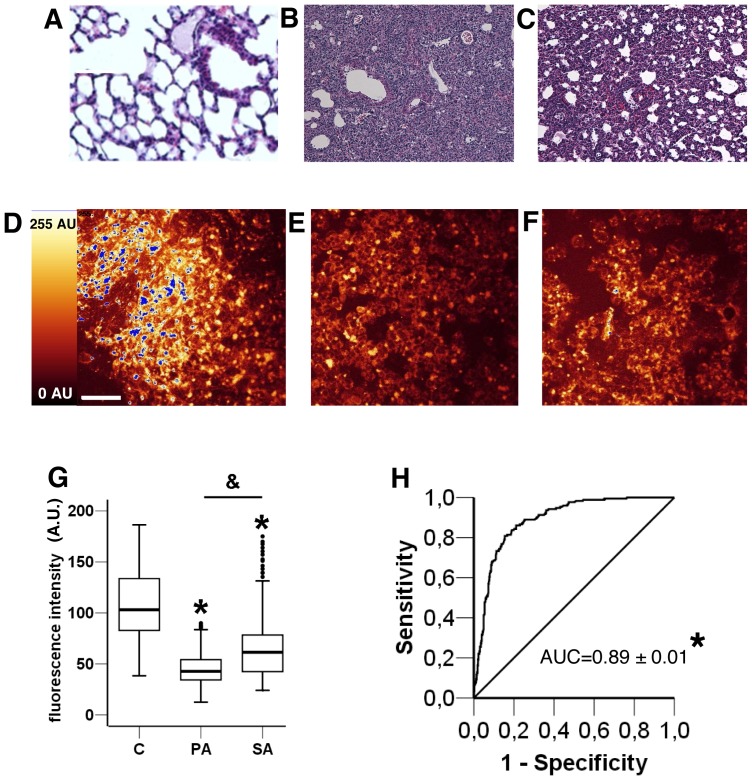
Fluorescence intensity and histology images of BAL in control and Pseudomonas aeruginosa- or Staphylococcus aureus–induced pneumonia mice.Control condition histology (A) and fluorescence intensity imaging (D); Staphylococcus aureus-induced pneumonia histology (B) and fluorescence intensity imaging (E); Pseudomonas aeruginosa-induced pneumonia histology (C) and fluorescence intensity imaging (F). Scale bar, 50 μm. (G) Boxplot representation of fluorescence intensity in arbitrary units (I (AU)) of BAL for non infected mice (control, C) and Pseudomonas aeruginosa (PA) or Staphylococcus aureus (SA) induced pneumonia in mice. Boxes represent median (interquartile range). Data are representative of two independent experiments (Control group, n = 8; Pseudomonas aeruginosa group, n = 9; Staphylococcus aureus group, n = 12). ANOVA with post-hoc analysis by t-test using Bonferroni's correction was used to compare autofluorescence levels between each group. *: p<10−4
Pseudomonas aeruginosa and Staphylococcus aureus groups versus control group. &: p<10−4
Pseudomonas aeruginosa group versus Staphylococcus aureus group. BAL and background noise intensities are different in each condition (p<10−4). (H) Receiver operating curve of fluorescence intensity of cells between controls and induced-infectious pneumonia in mice. AUC ± Standard Error: area under curve. *p<10−4.